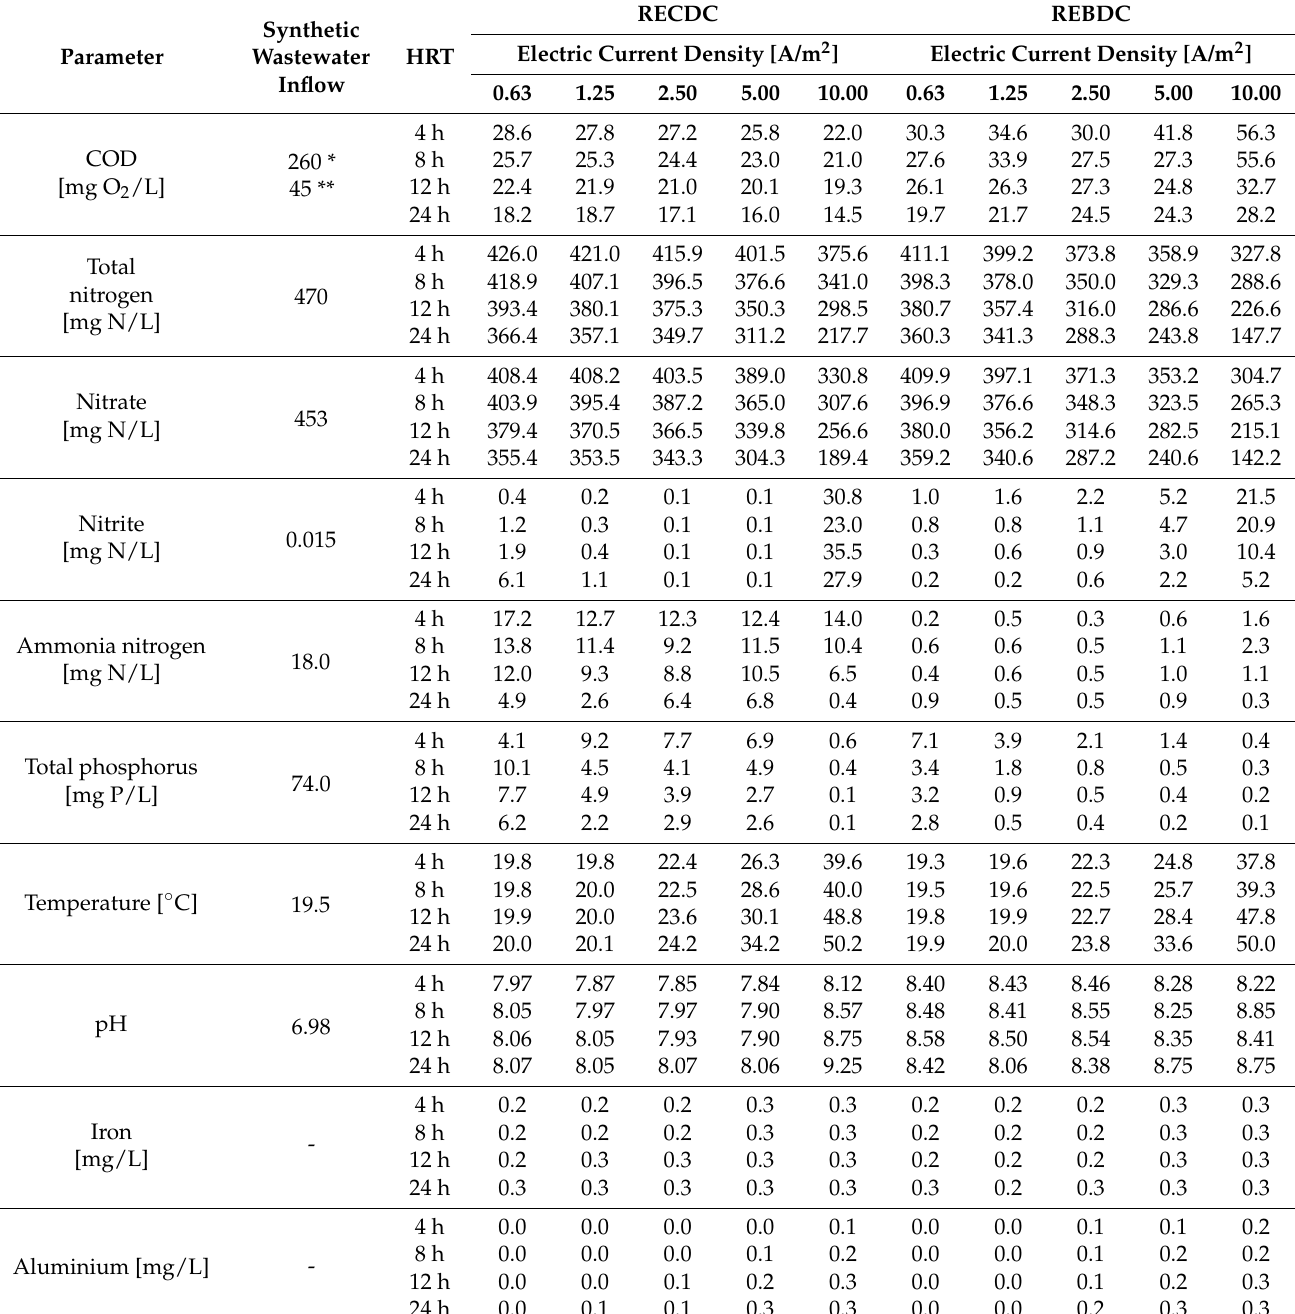
Table 3. Quality of wastewater treated in the RECDC and in the REBDC (mean